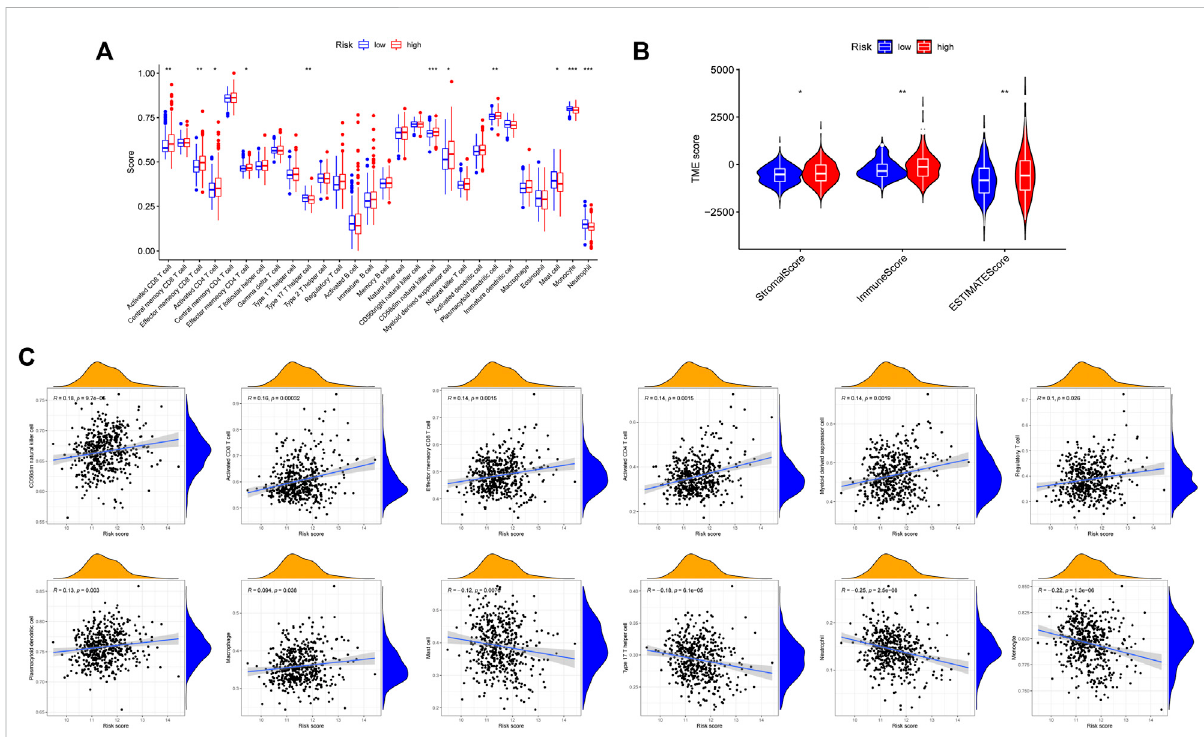
FIGURE 11 Comparison of immune microenvironment in high and low risk groups. (A) Differences in 28 immune cell in fi ltration between high and low risk groups by ssGSEA. (B) Differences in ImmuneScore, StromalScore and ESTIMATEScore between high and low risk groups. (C) Correlation between risk score and immune